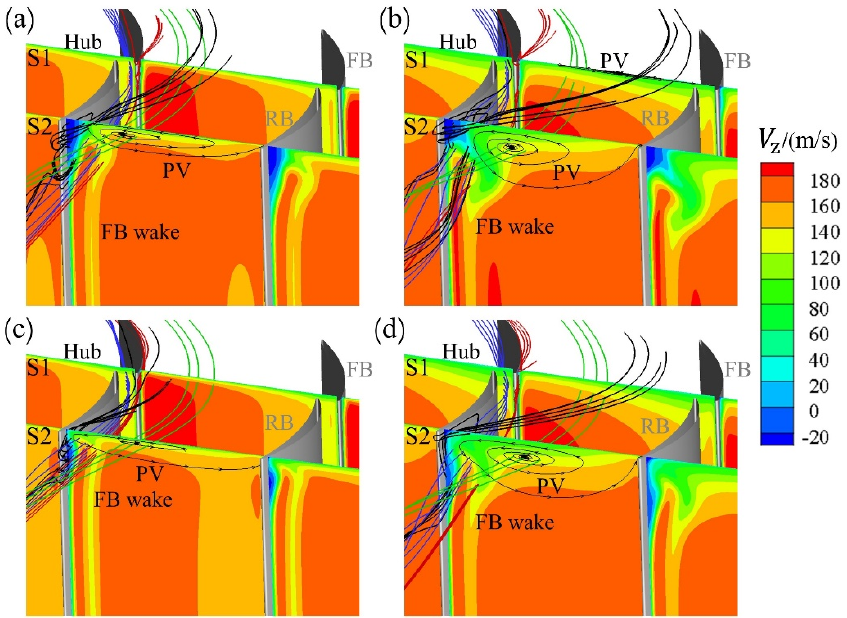
Figure 15. The 3D streamlines of the blade passage and V z contours at 0 ◦ incidence angle under different IBL conditions: ( a ) 0 mm collateral; ( b ) 5 mm collateral; ( c ) 0 mm skewed; ( d ) 5 mm skewed.